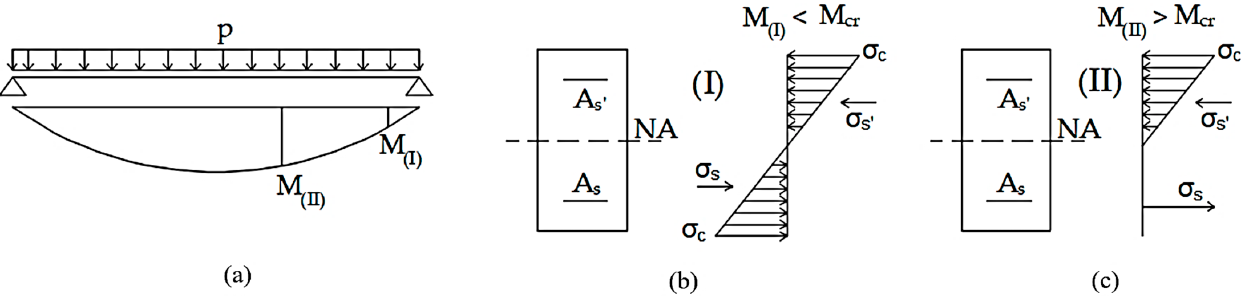
Figure 6. ( a ) Simply supported beam with distributed load, ( b ) cross-section stress at the state I and ( c ) at state II.